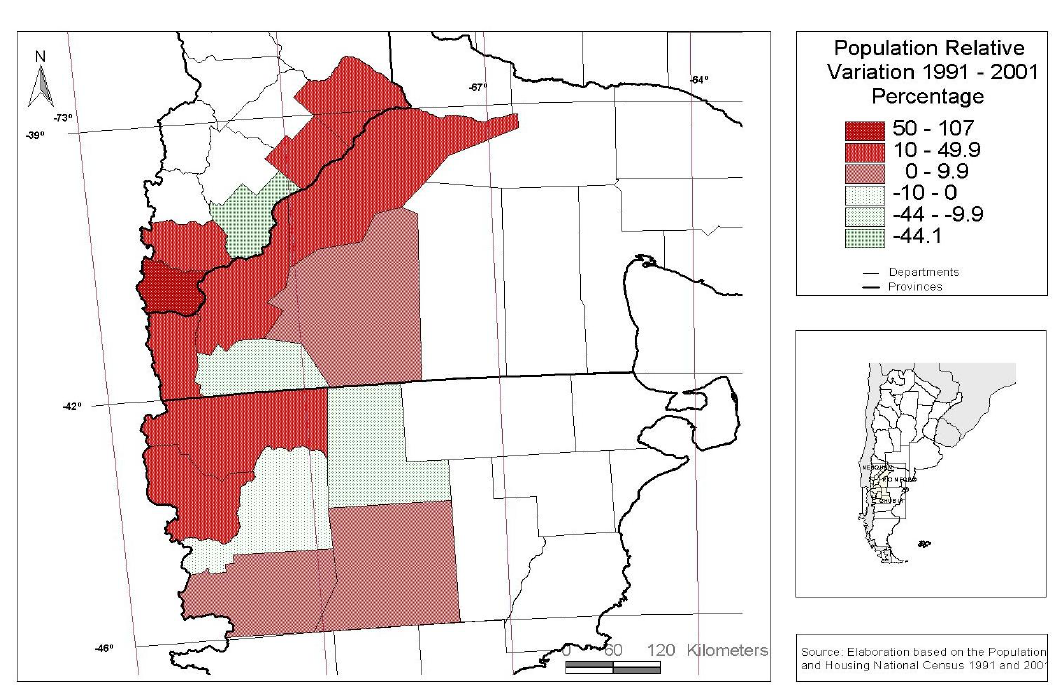
Figure 5. Percentage of urban population in the studied region in 2001, adapted from